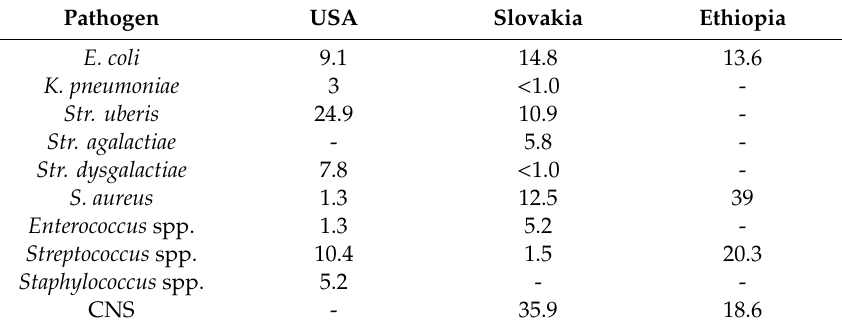
Table 1. Prevalence of pathogens isolated from milk of dairy cows in